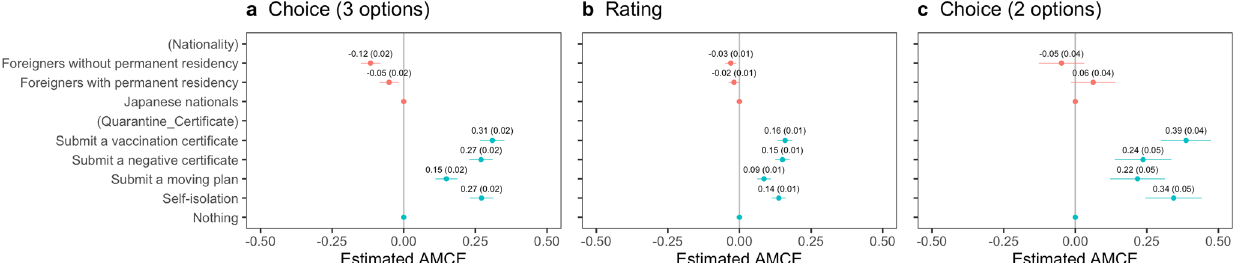
Fig. 2 Uniform average marginal component effects of Nationality and Quarantine_Certi fi cate on the probability or rating for travelers ’ entry with error bars of 95% con fi dence intervals. The vertical lines (0.0) show no effects for Panel a using the choice-based question (three options including “ Neither should be admitted ” ), Panel b using the rating-based question, and for Panel c using the choice-based question (two